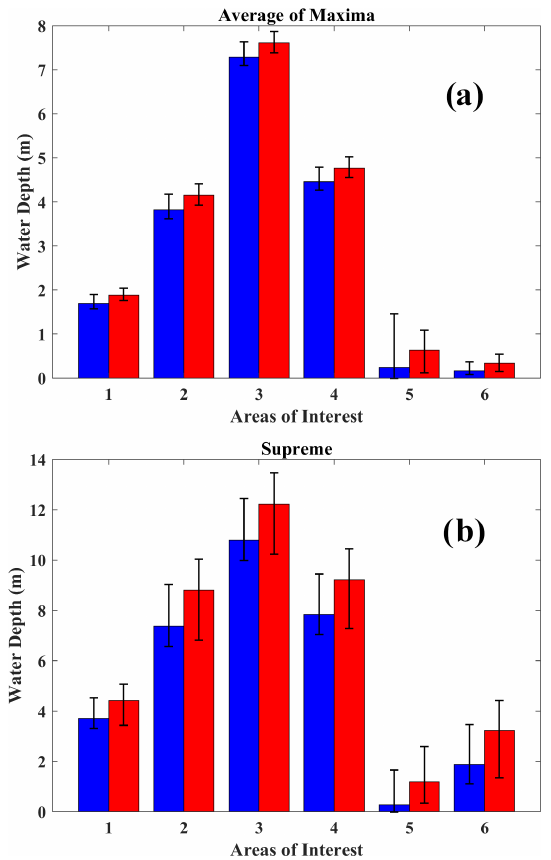
Figure 10. (a) Mean of maxima and (b) supremum water depths in important areas of Ourense for the historical (blue) and future (red) periods considering the average of all models. Areas under analysis are named from 1 to 6: Chavasqueira thermal baths, Oira Park, Antena fluvial beach, Ribeira de Canedo park, Miño park, and the N-120 road. Black bars represent the multi-model